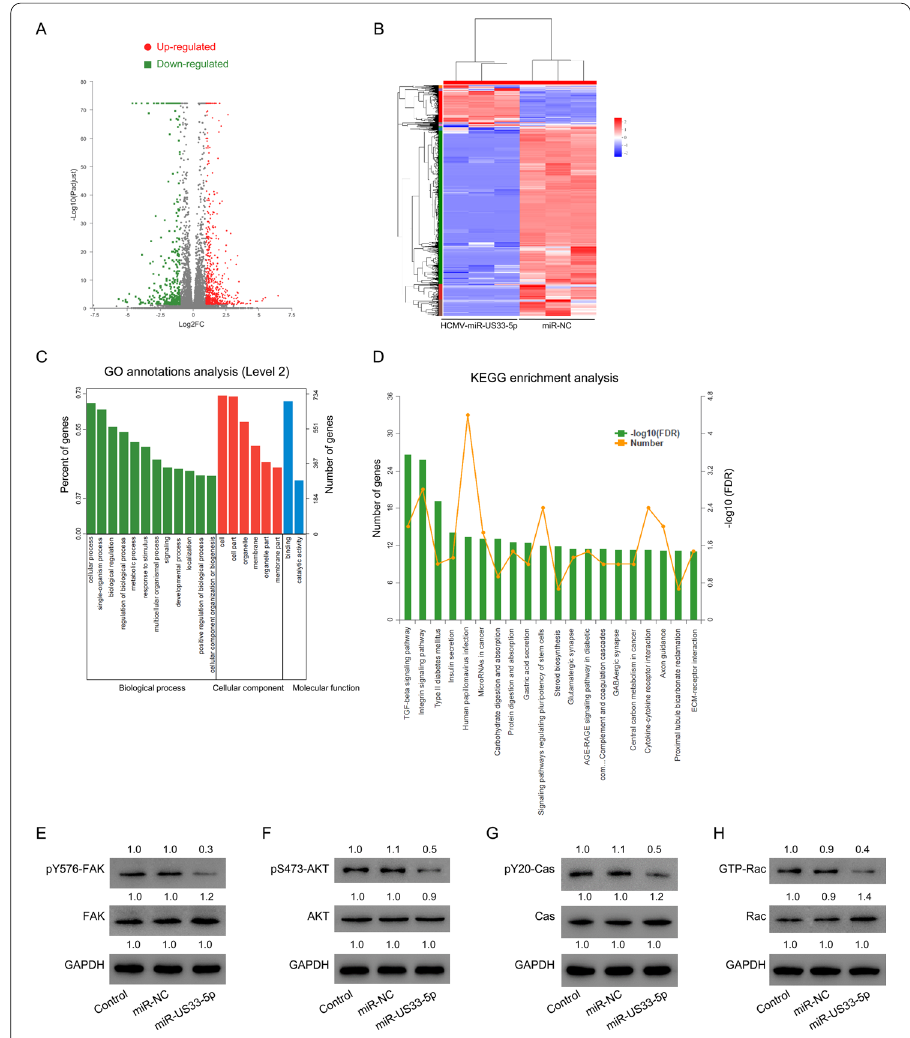
Fig. 3 HCMV-miR-US33-5p inhibits key factors of integrin signaling pathway in HA-VSMCs. A Volcano plot for DEGs in the control ( n 3) and HCMV-miR-US33-5p transfection ( n 3) groups. Green and red points = = represent genes downregulated and upregulated in the HCMV-miR-US33-5p transfection group, respectively. B Heatmap for DEGs in the control ( n 3) and HCMV-miR-US33-5p transfection ( n 3) groups. C GO = = annotations; D KEGG enrichment analysis. E – H Western blot analysis of p-FAK ( E ), p-AKT ( F ), pY20 CAS ( G ), and GTP-Rac ( H ) in HA-VSMCs. Western blot was performed three times; representative images are presented. Numbers above lanes indicate the relative protein level, normalized relative to the control samples